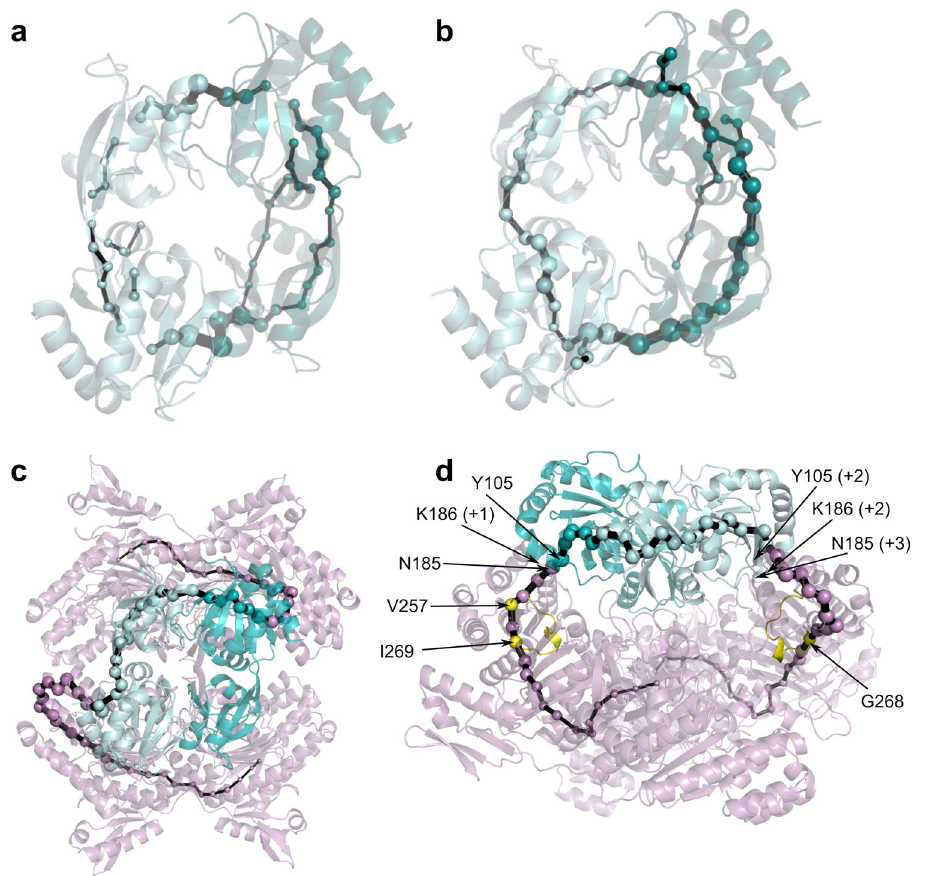
Fig. 5| Effect of Pa HisZbindingon Pa HisG S dynamic network. a SPManalysis of nonactivated Pa HisG S dimer. b SPM analysis of activated Pa HisG S dimer upon Pa HisZbinding(onlythecatalyticsubunitsareshown). c SPManalysisof Pa ATPPRT including Pa HisZ residues. d Side view (90° rotation) of c . Pa HisG S monomers are shown in light and dark teal, while Pa HisZ is shown in pink. The histidine-binding loop (D256 – I269) is shown in yellow in d . The sizes of the edges (black lines) and